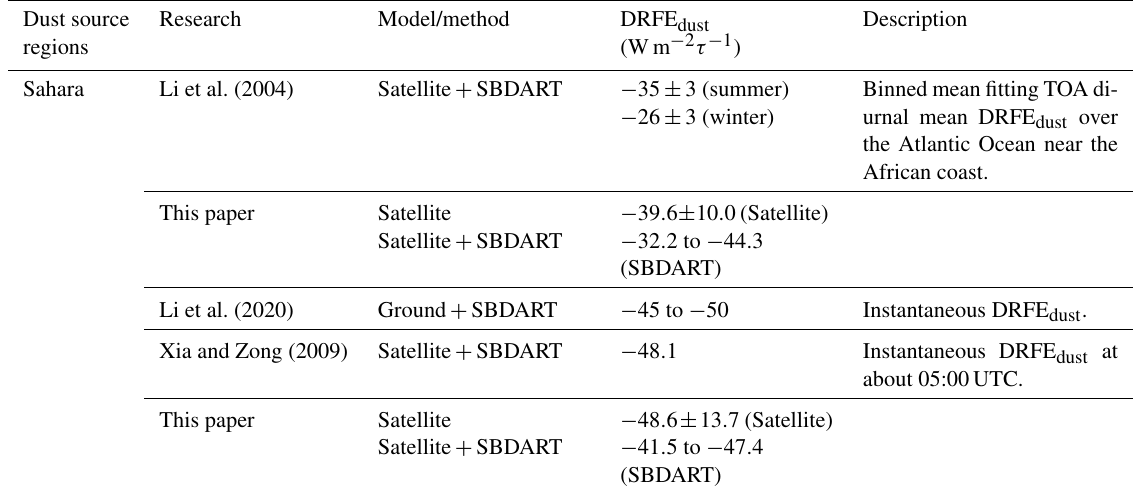
Table 2. SW DRFE dust from different studies. Dust source